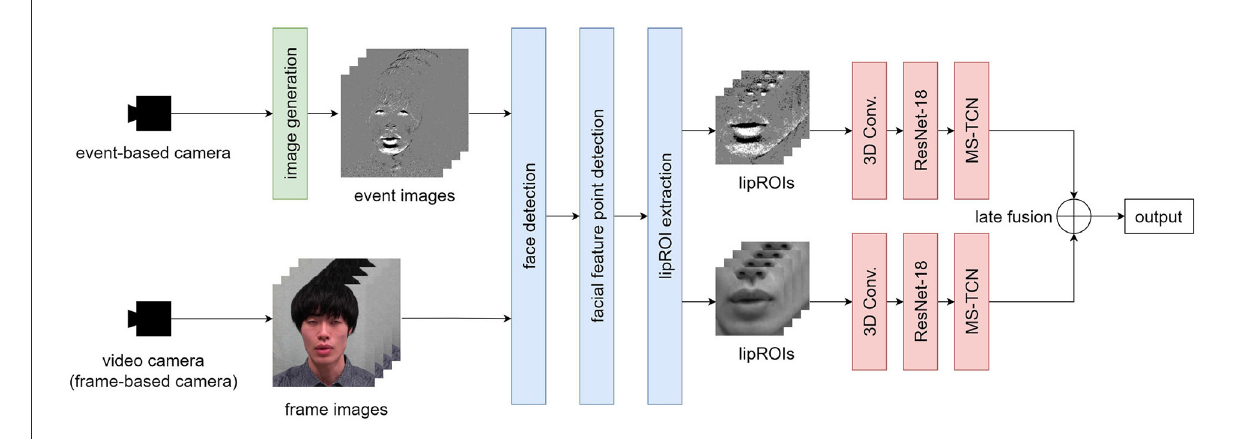
FIGURE1 Processing pipeline of the proposed method.